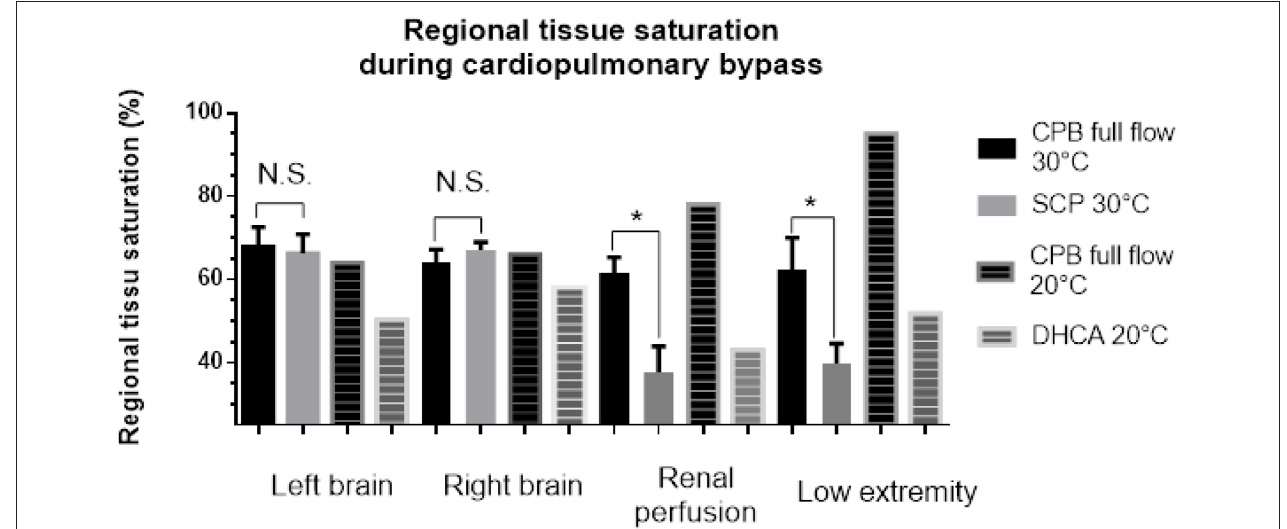
FIGURE 2 | Tissue saturation in different organs in selective cerebral perfusion patients under mild hypothermia and deep hypothermic cardiac arrest patients.